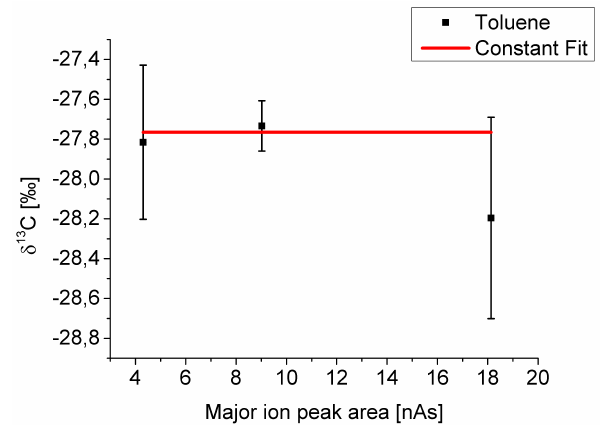
Fig. 4. VOC mixing ratios versus detector response for three dilution steps of standard B; each data point is the average of four to six measurements. The error bars of the VMR reflect the uncertainty of standard B’s composition as well as the uncertainty of the dilution process, the error bars of the average peak areas represent the standard errors. Most error bars are smaller than the symbol size.